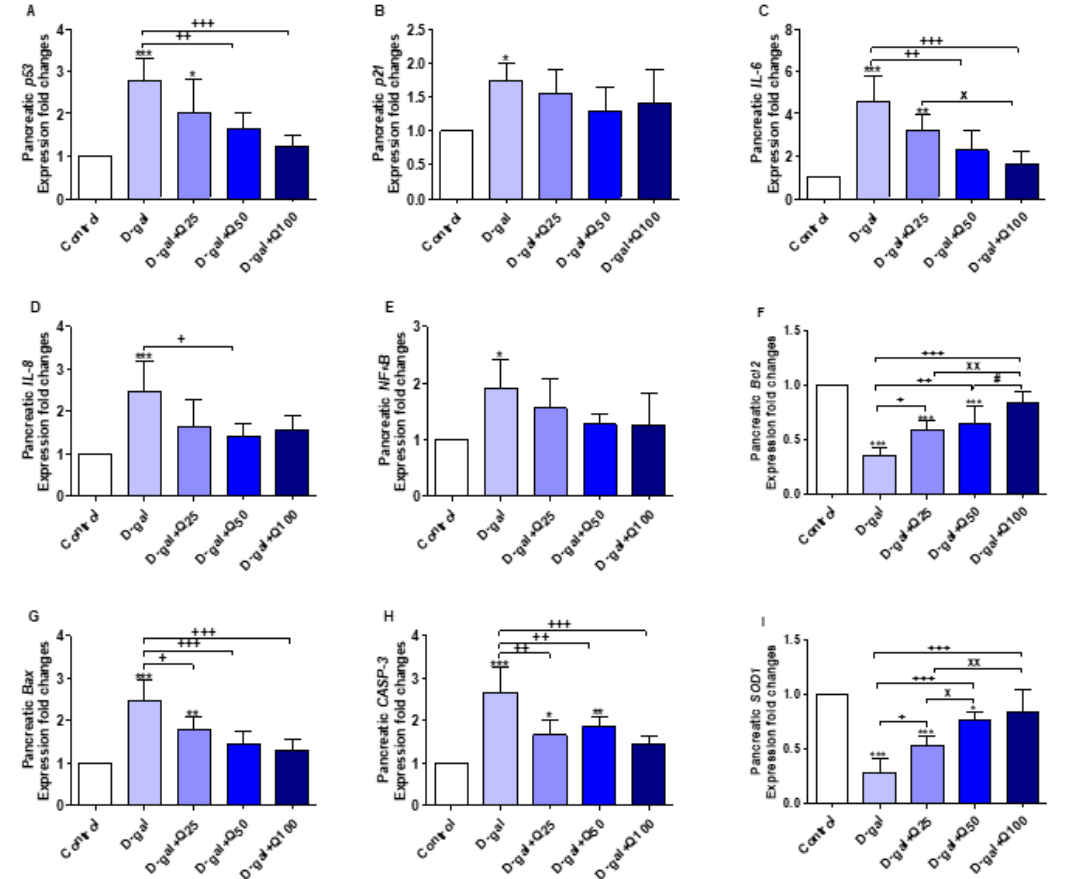
Figure 6. Expression of fold changes of pancreatic ( A ) p53 , ( B ) p21 , ( C ) interleukin-6 ( IL-6 ), ( D ) interleukin-8 ( IL-8 ), ( E ) nuclear factor-kappa B ( NF- κ B ), ( F ) B-cell lymphoma 2 ( Bcl2 ), ( G ) Bcl-2- associated X protein ( Bax ), ( H ) caspase-3 ( CASP-3 ), and ( I ) Cu, Zn-superoxide dismutase ( SOD1 ) mRNA levels: Data were analyzed with one-way ANOVA followed by Tukey’s multiple comparison test. * p < 0.05, ** p < 0.01, and *** p < 0.001 vs control. + p < 0.05, ++ p < 0.01, and +++ p < 0.001 vs D-gal. x p < 0.05 and xx p < 0.01 vs D-gal+Q25. # p < 0.05 vs D-gal+Q50. Error bars represent mean ± SD. n =